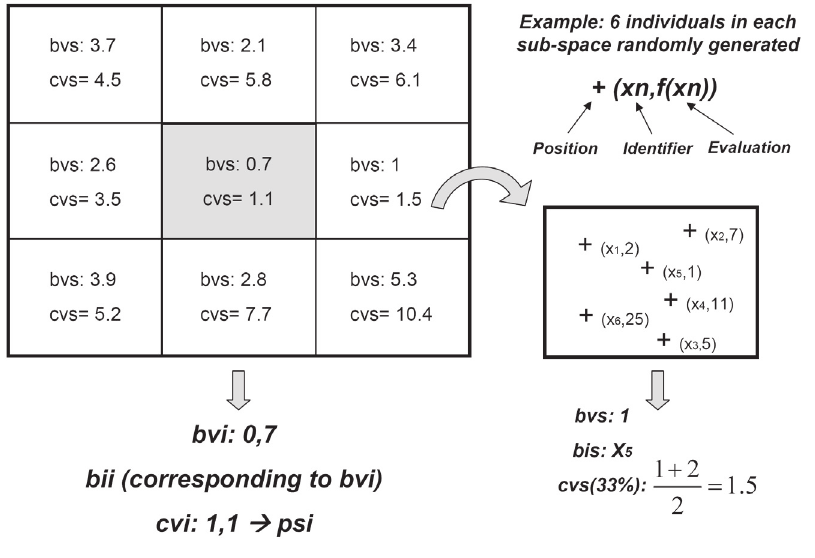
Fig. 2. Sub-space evaluation and selection of the most promising